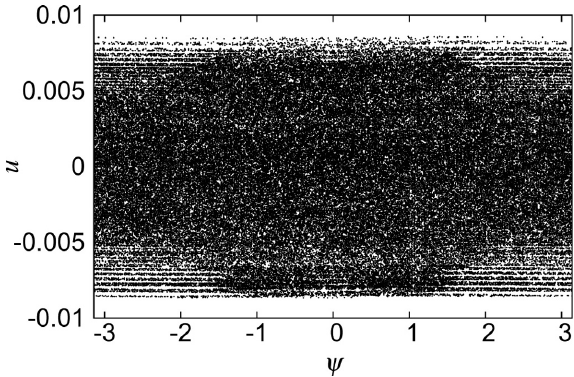
Fig. 9. Phase space u − ψ for the map (94) at Q = 0 . 98 × 10 − 4